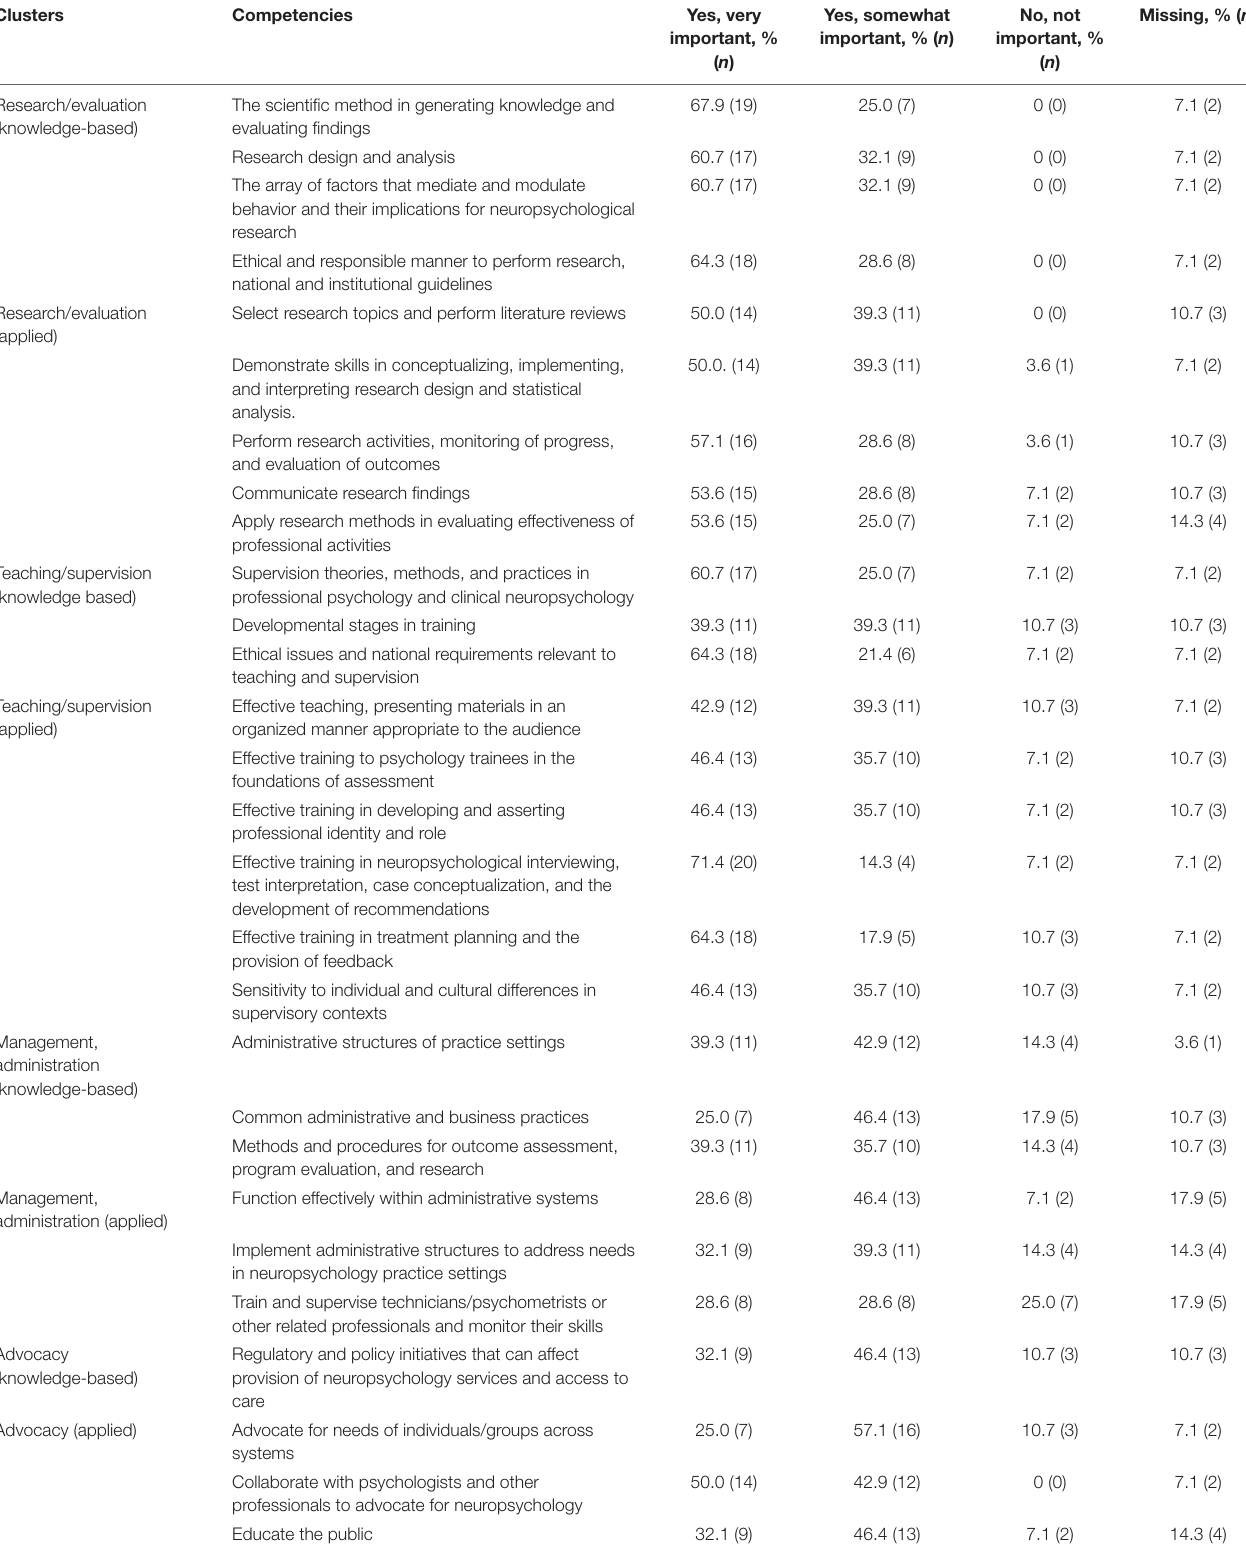
TABLE 3 | Percentage of respondents giving an affirmative response on items pertaining to additional functional competency areas relevant to clinical neuropsychology (research/evaluation, teaching/supervision, management/administration, and advocacy): ratings given as somewhat important, very important or not important.